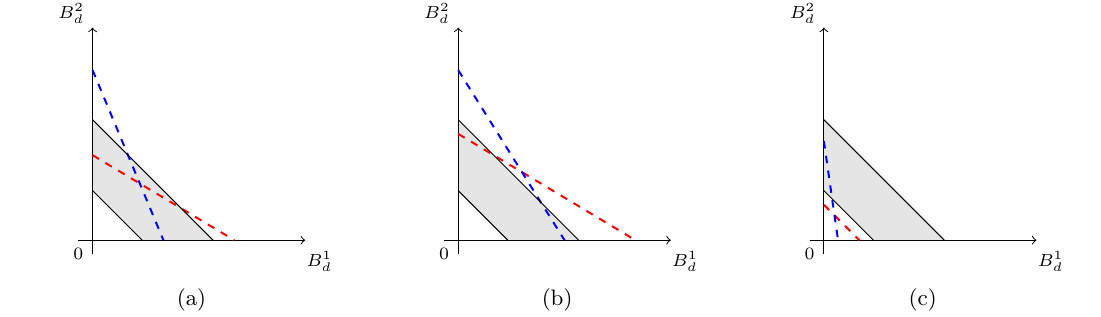
Figure 1: NE analysis for static resource allocation game.